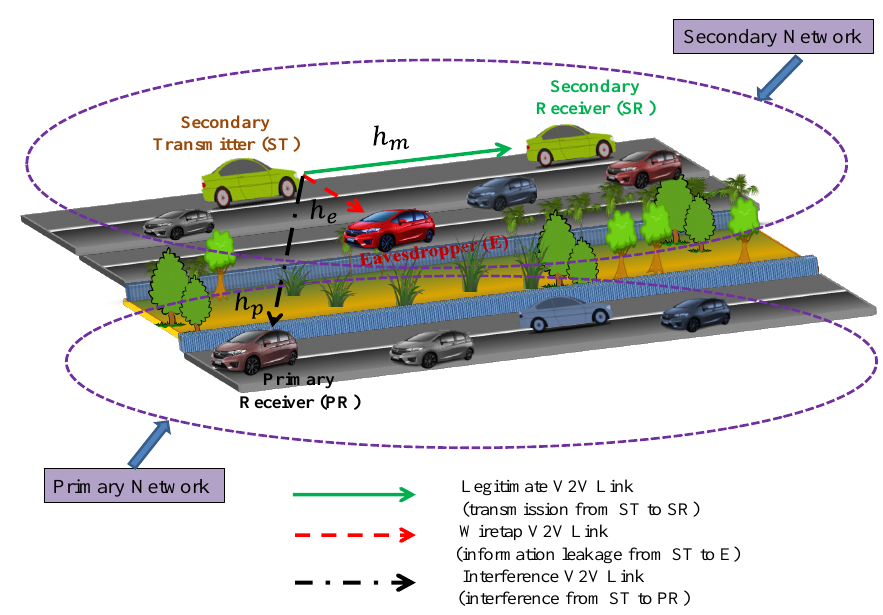
Figure 1. System model for the considered secure underlay